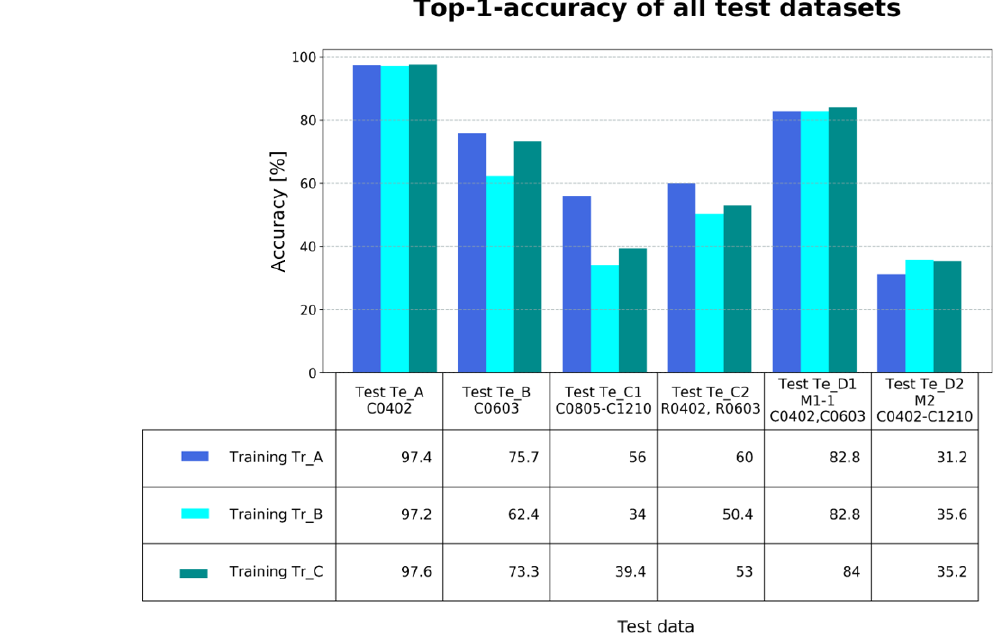
Figure 3. Top-1 accuracy of all test datasets with the homogeneous training datasets Tr_A, Tr_B, and Tr_C.